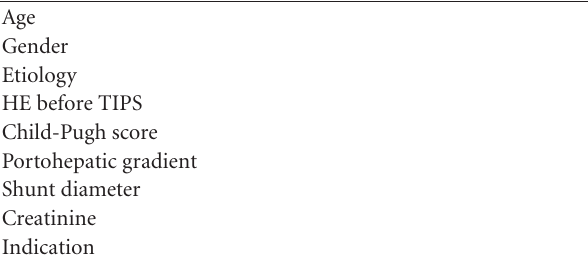
Table 4: Risk factors for post-TIPS encephalopathy.